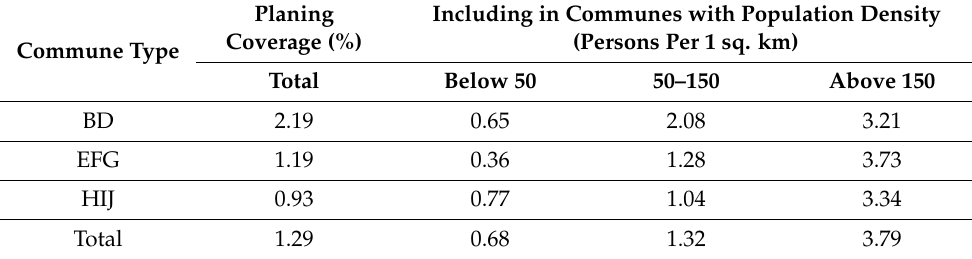
Table 3. Share of the area of communes with the production function planned in the local plans, for the year